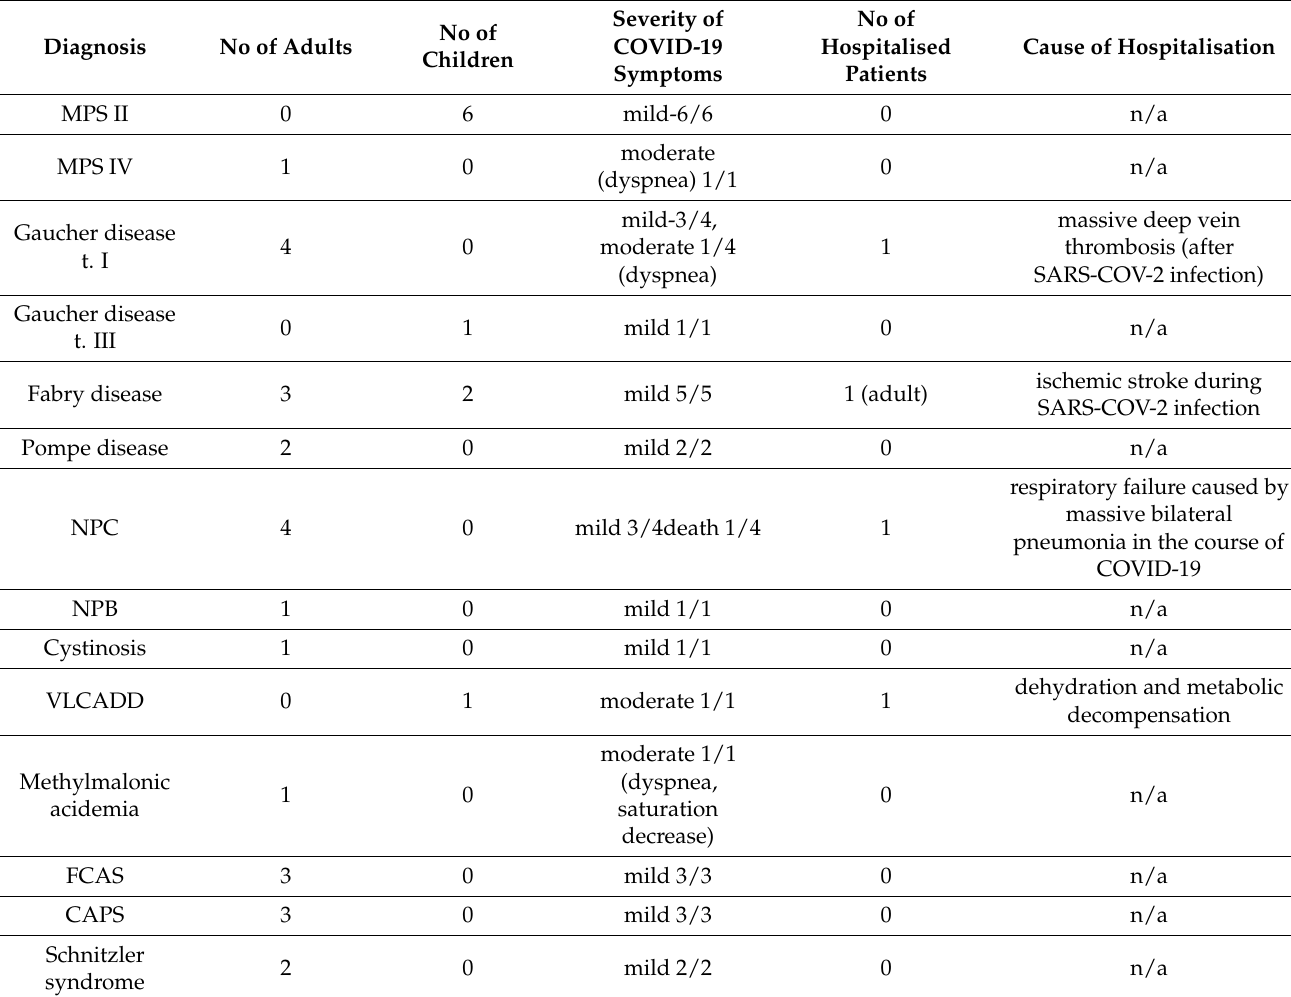
Table 2. Characteristic of patients with COVID-19